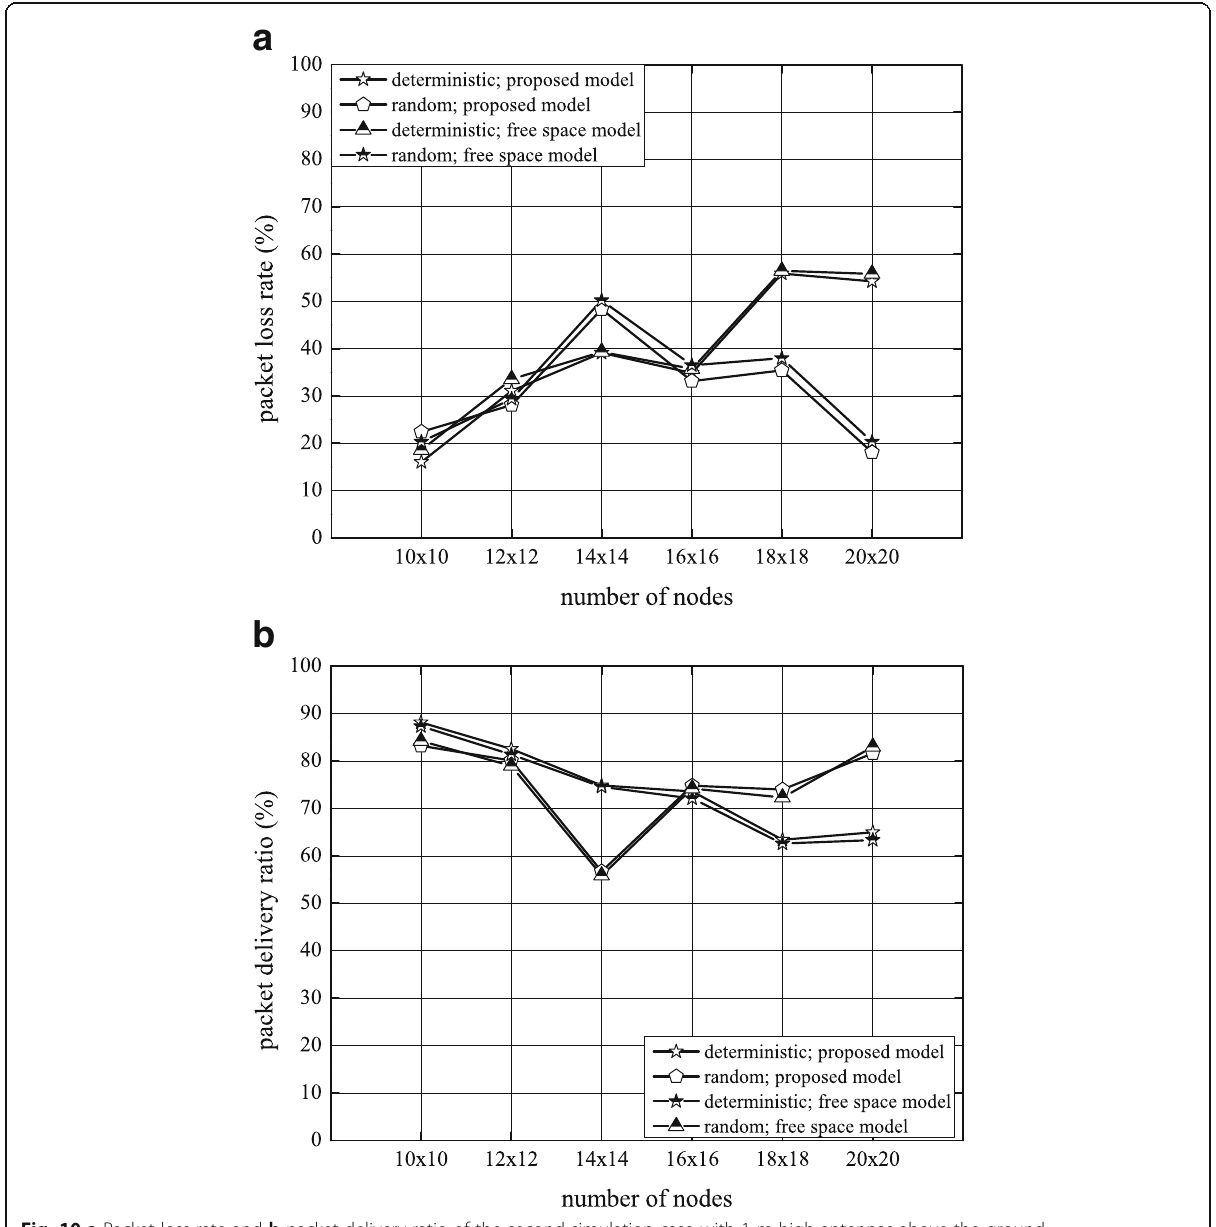
Fig. 10 a Packet loss rate and b packet delivery ratio of the second simulation case with 1-m-high antennas above the